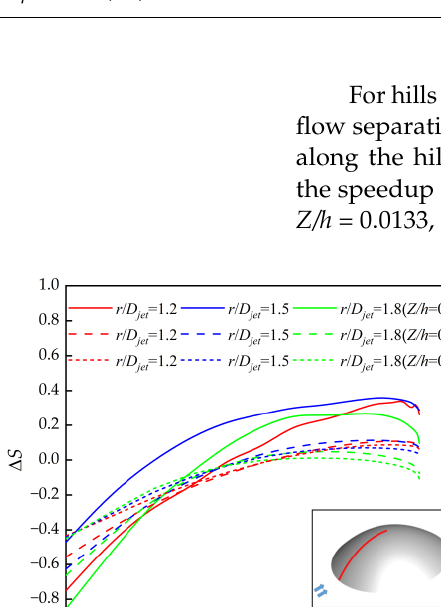
Figure 6. Hilltop speedup ratio at different radial positions.